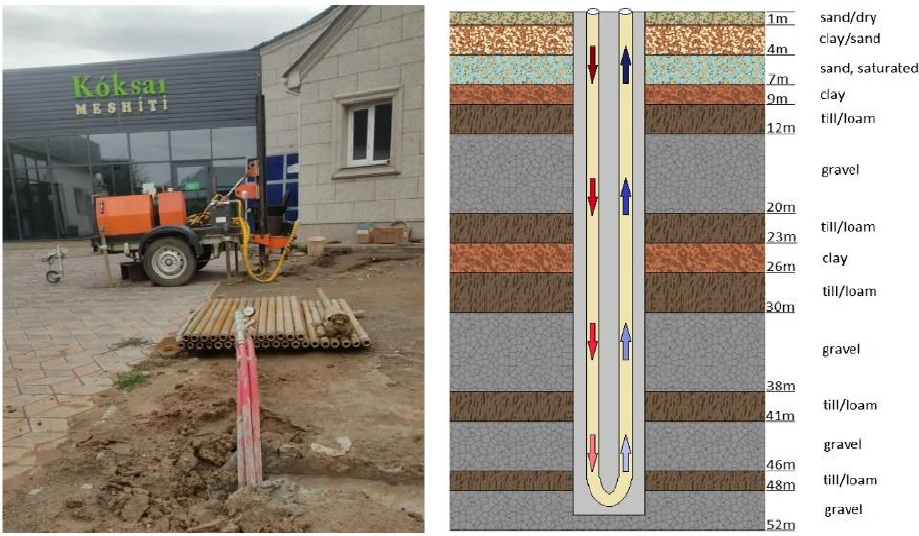
Figure 2. Geological structure defined during the drilling.